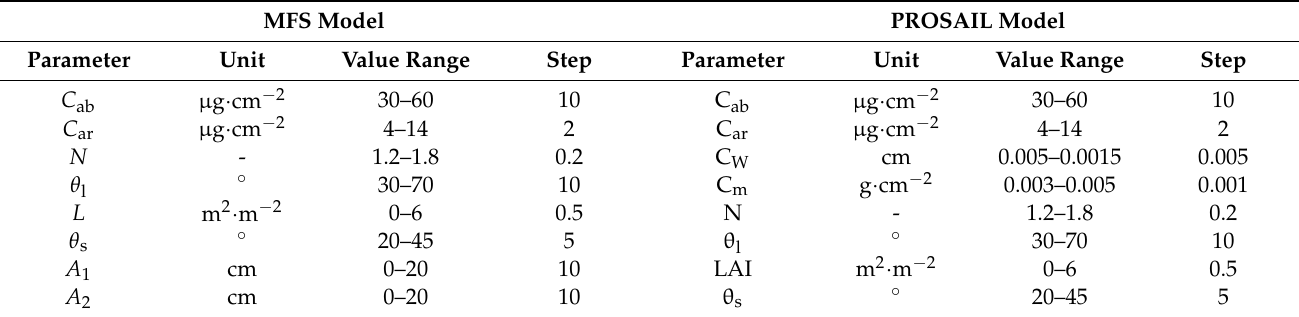
Table 1. The input parameters for the MFS model used to generate the learning dataset. MFS Model PROSAIL